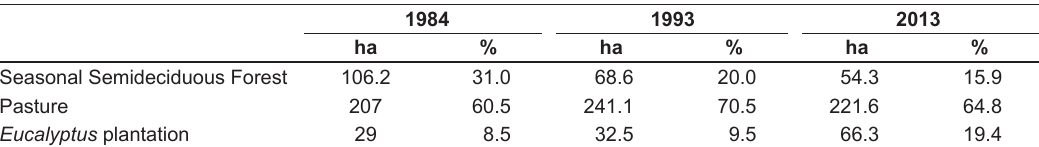
Table 1. Number of hectares (ha) and percentage (%) of the different land uses near the study area, in the years of 1984, 1993 and